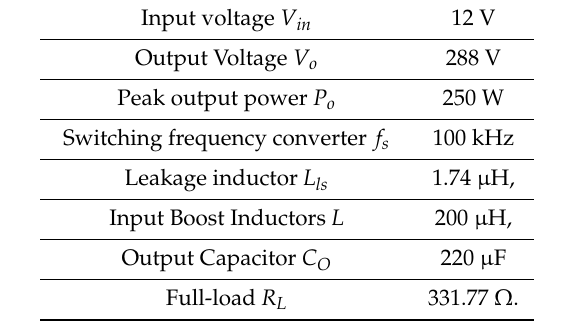
Table 1. Design specifications for the control system of the converter.